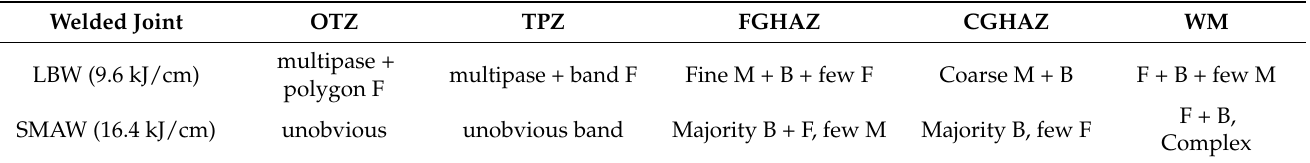
Table 3. Microstructure comparison between two